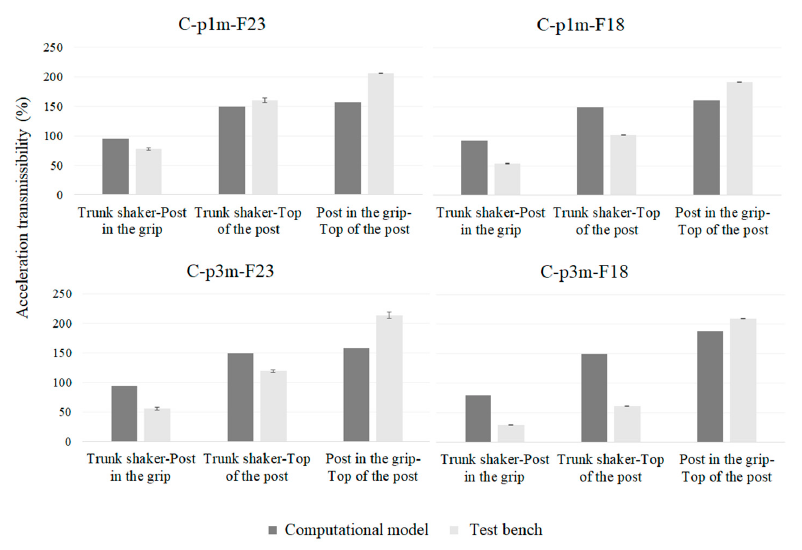
Figure 7. Acceleration transmissibility (%) between Trunk shaker–Post in the grip, Trunk shaker– Top of the post, and Post in the grip–Top of the post for the configuration